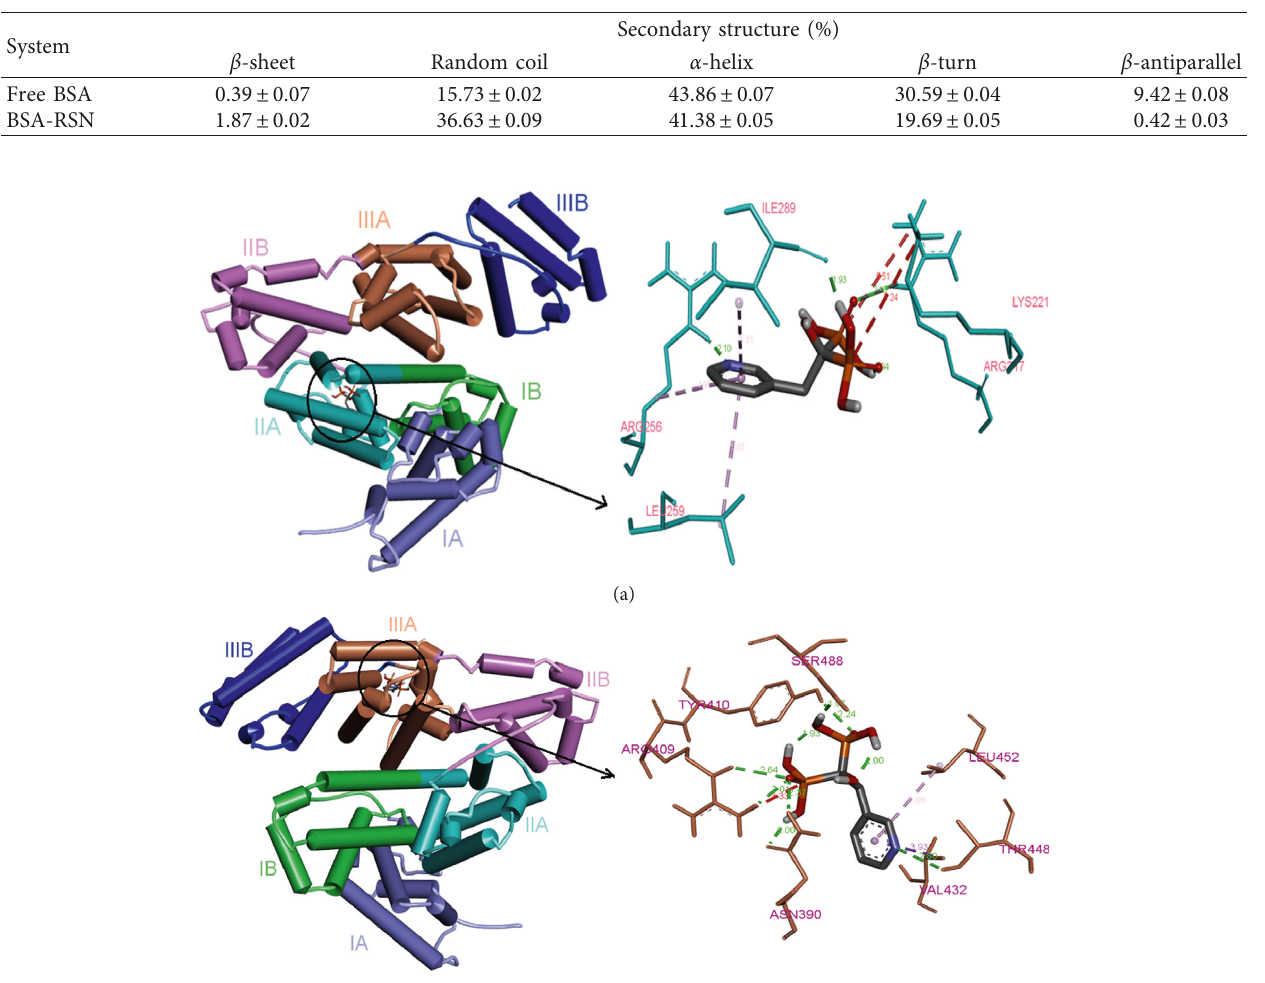
Table 5: FT-IR spectral measurements of the secondary structure of BSA during interaction with RSN at 297K and pH 7.40.